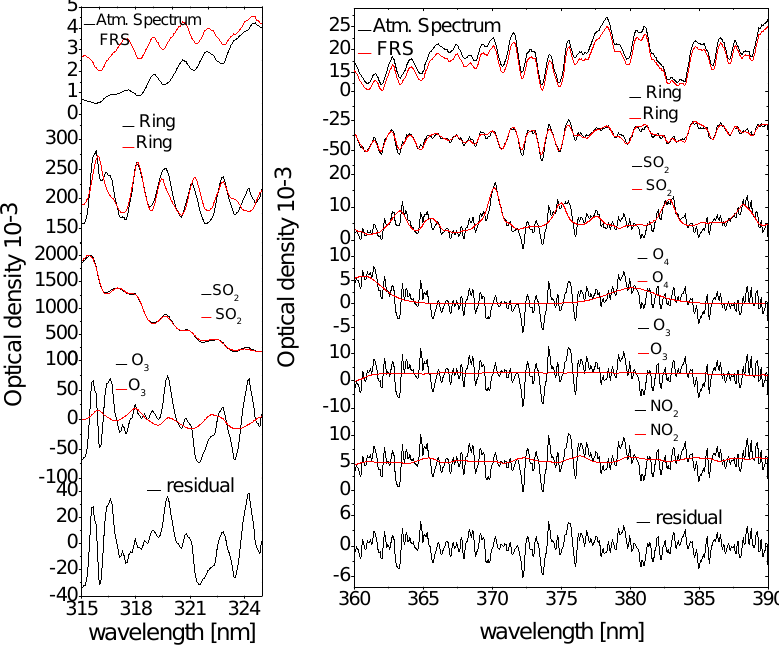
Fig. 1. Example of the DOAS SO 2 -Fit. Black lines: measured spectra, red lines: reference spectra, the atmospheric spectrum was taken inside the volcanic cloud of Etna ( α =9 ◦ ) on 10 June 2008 at 11:22 local time (a) evaluation in the short wave UV window 315–325nm (b) evaluation in the long wave UV window